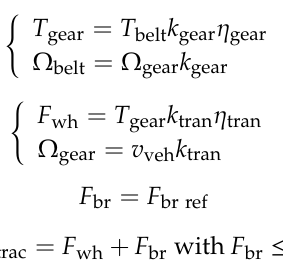
Figure 2. EMR and control of the studied system.